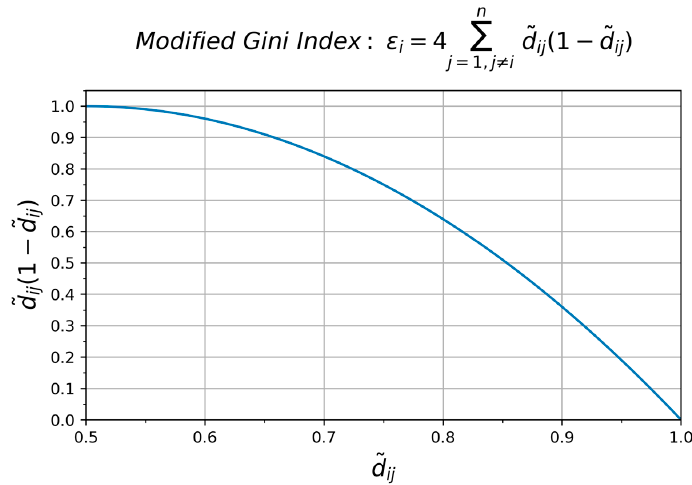
Figure 1. The modified Gini Index curve.